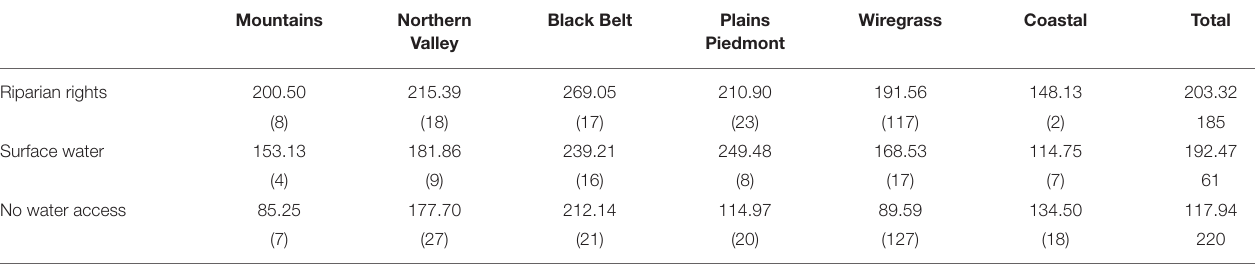
TABLE 2 | Average acreage of parcels with existing center-pivot irrigation (2006) by region and water access.